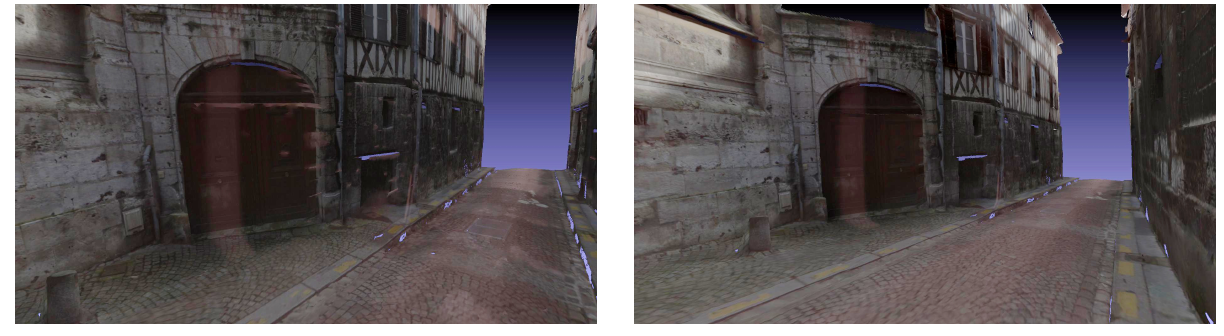
Figure 8. Textured scene before (a) and after color adjustment